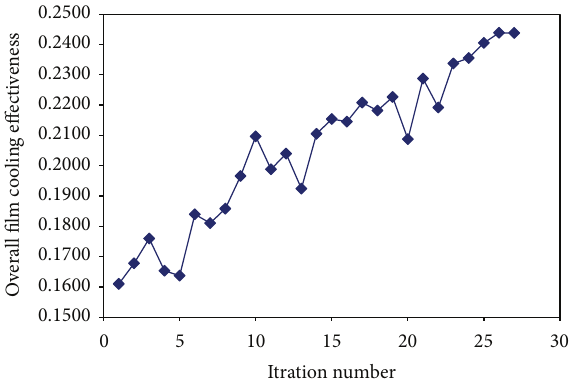
Figure 31: Optimization history of flat plate film cooling